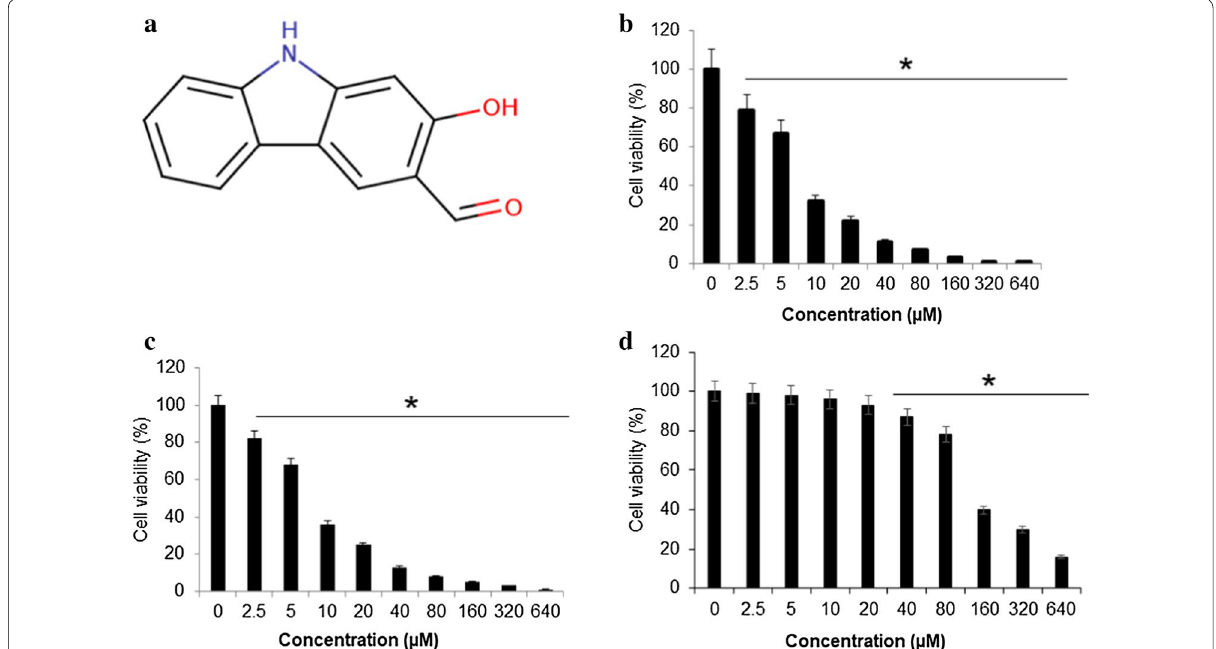
Fig. 1 Mukonal inhibits the growth of breast cancer cells. a Chemical structure of mukonal molecule. b The viability of SK-BR-3 breast tumor cells after being subjected varying mukonal concentration as indicated. SK-BR-3 cells were exposed to mukonal for 48 h and then subsequently stained with MTT solution for calorimetric analysis. c The viability of MDA-MB-231 breast tumor cells after being subjected varying mukonal concentration as indicated. d The viability of normal MB-157 breast cells after being subjected varying mukonal concentration as indicated. All the experiments were executed three times and data was shown as mean SE (standard error). The p value of < 0.05 was taken as a statistical significant figure ±